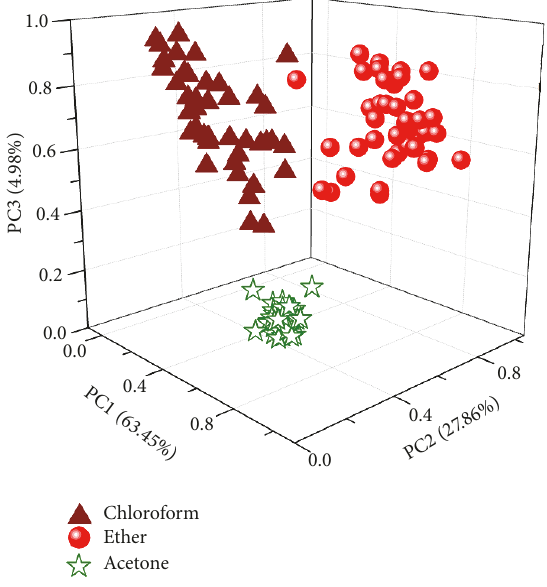
Figure 7: The scatter plot of diverse molecules response curves after DPP and PCA.